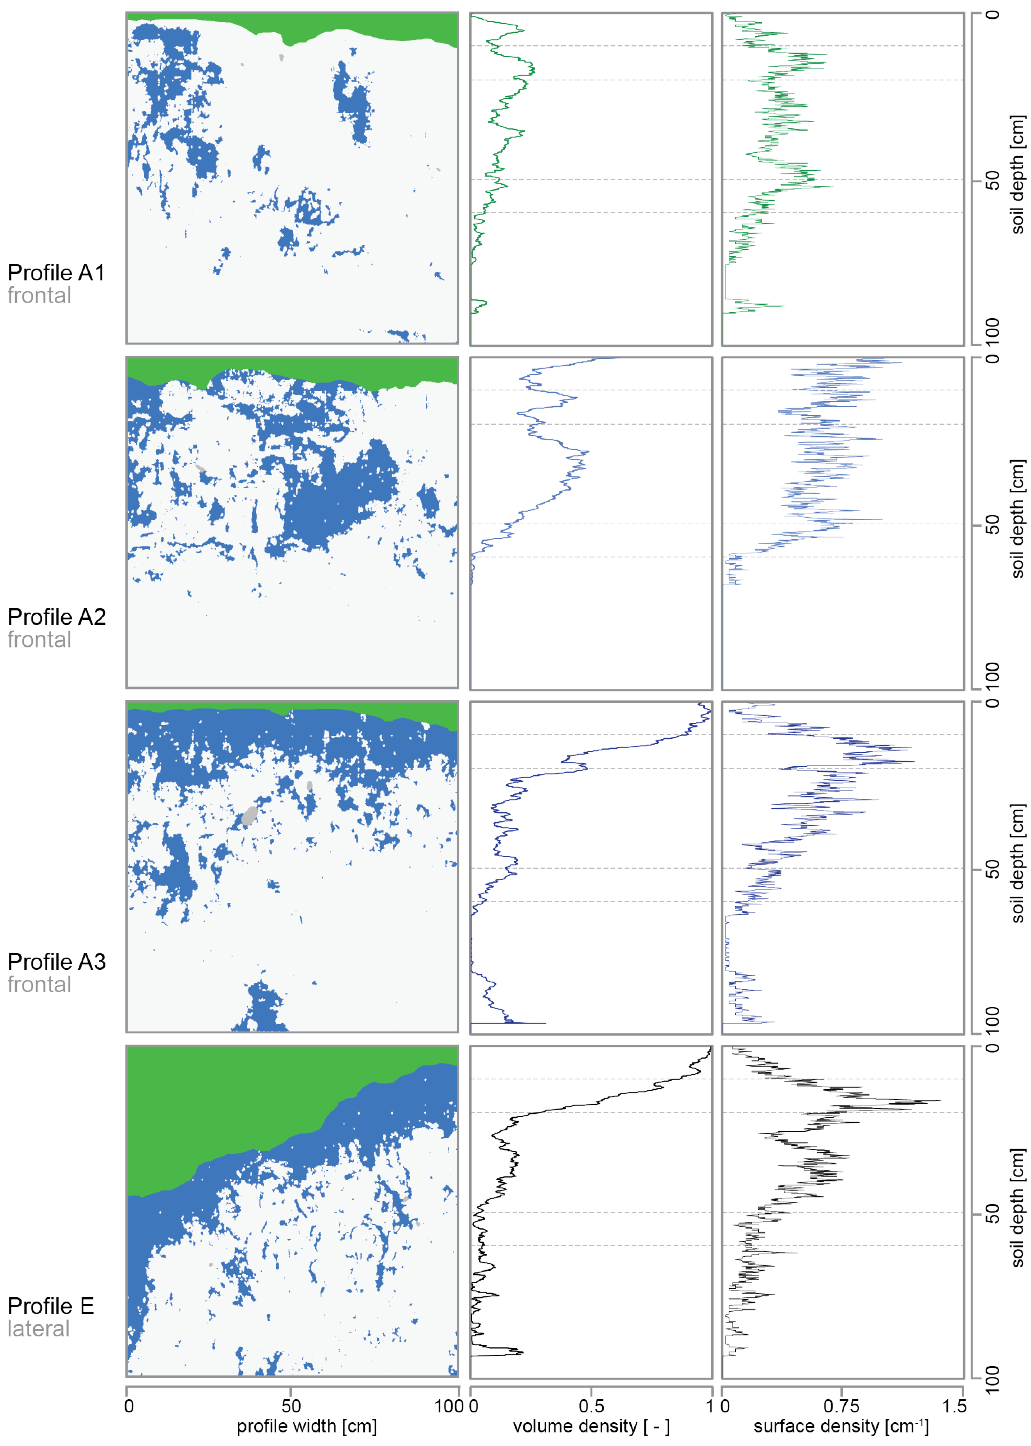
Fig. 6. Brilliant blue dye pattern (blue), surface topography/grass (green), and obstacles, e.g., stones (gray) together with its numerical representation in relation to the soil surface (interface green/blue) for selected profiles A1, A2, A3 and E. Volume density (VD) illustrates the dye coverage per soil depth. Low values of VD represent a low abundance of the dye (e.g., bypassing the soil matrix), whereas high values indicate a high abundance of the dye (e.g., complete matrix staining in the H horizon). Surface density (SD) illustrates the vertical distribution and dimension (size) of dye-stained structures in the soil profiles. The frontal profiles A1–A3 and the lateral profiles E are 2.0, 1.5, and 1.0m downhill of the irrigation plot (see Fig. 2). Low values of SD represent few but, large structures (e.g., matrix flow in H horizon); high SD-values indicate many, but small dye-stained objects (e.g., macropores in Go horizon).